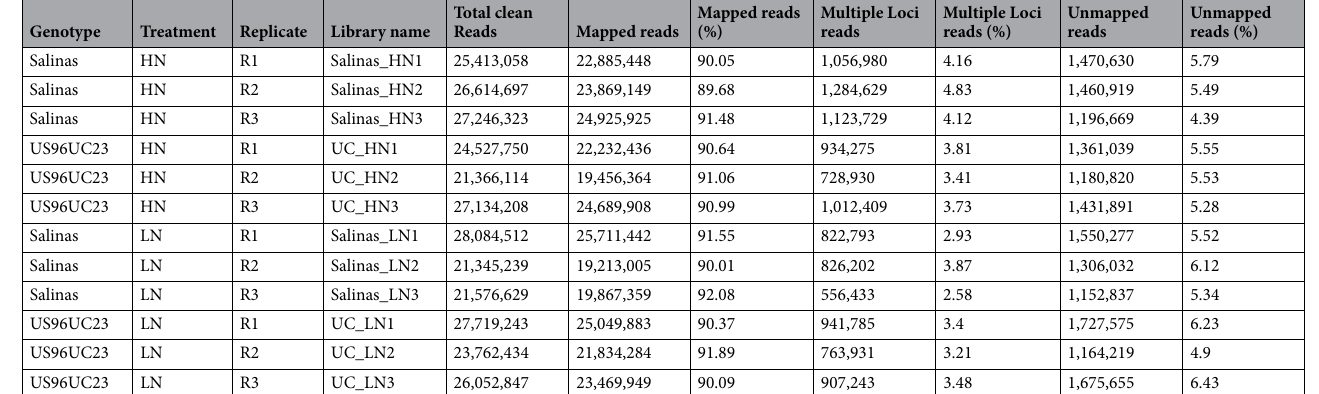
Table 1. Summary of RNA-Seq performed on two lettuce genotypes under high nitrogen (HN) and low nitrogen (LN) treatments.